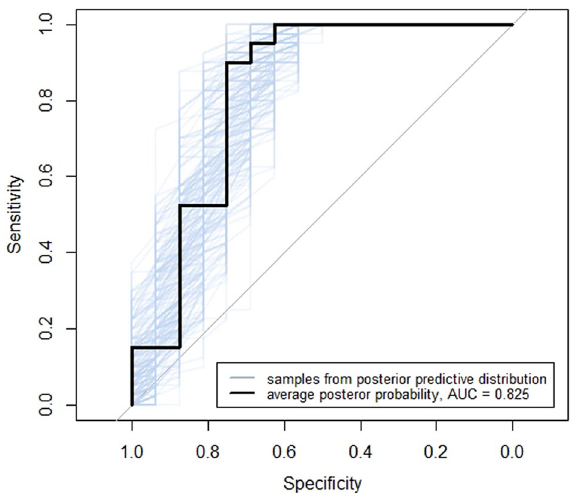
Figure 6. Receiver operating characteristic (ROC) curve of posterior probability of correct species assignment using spectra ratio from leave-one-out cross validation. Full leave-one-out cross validation with spectra data was performed and a ROC curve generated using the mean of the posterior predictive distribution for each unseen sample, and the area under the curve (AUC) calculated. For the prediction of whether the top hit species (by spectra ratio) was correct, the AUC was 0.825.